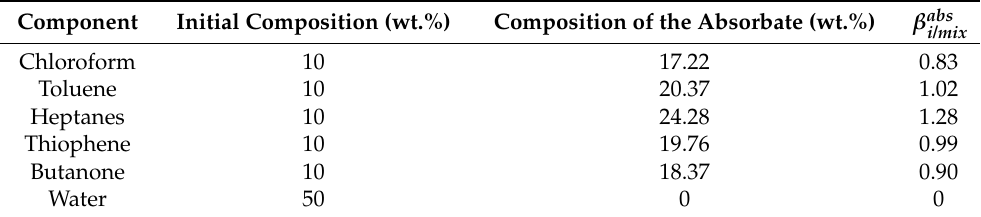
Table 8. Composition of the mixture before, after swelling, and the selective absorption of the membrane factor of the SILICONE1200 membrane. Component Initial Composition